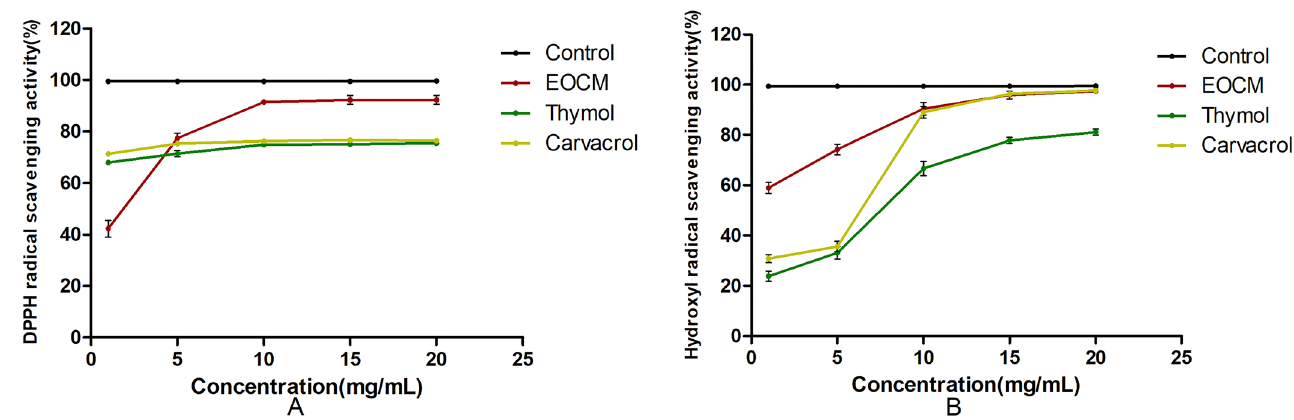
Figure 10. ( A ) is DPPH radical scavenging activity of EOCM, thymol and carvacrol. ( B ) is hydroxyl radical scavenging activity of EOCM, thymol and carvacrol. Error bars represent the standard deviations (SD) of the means from three biological replicates ( n = 3) in an individual experiment.